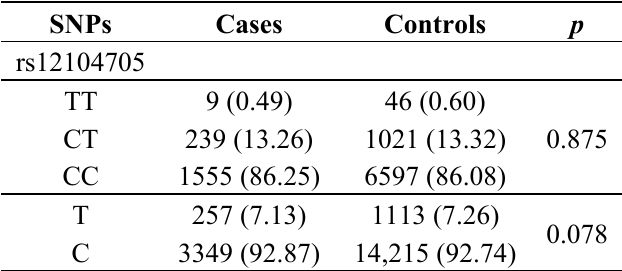
Table 8. Genotypic and allelic distributions of rs12104705 in GCG gene among Han Chinese.